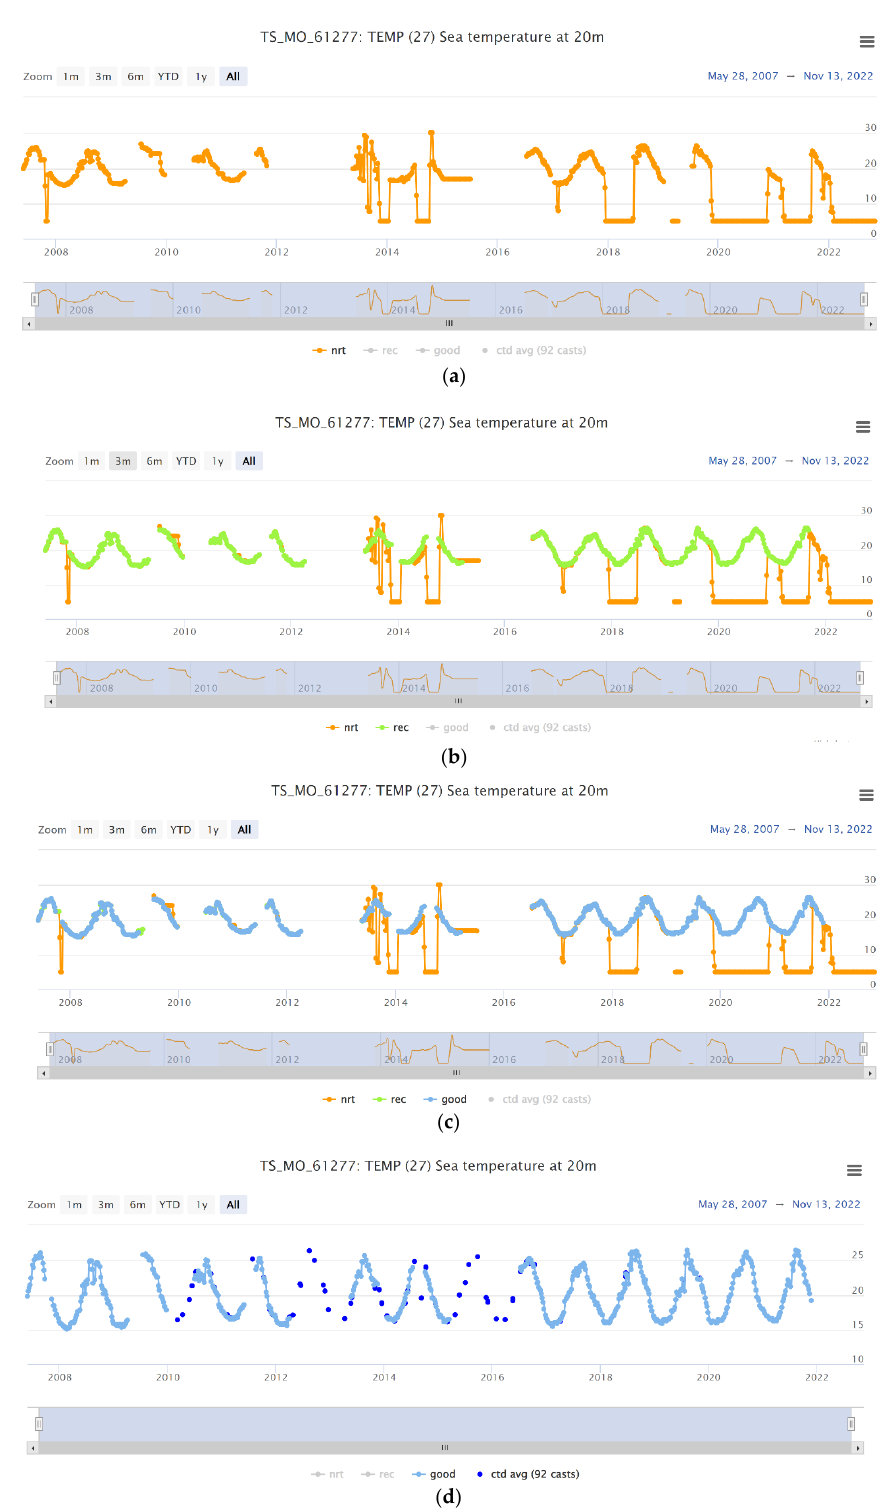
Figure 8. The POSEIDON buoys data flow using as an example the E1M3A 20 m temperature timeseries. Panel ( a ) corresponds to the NRT data received for the station during the deployment period. Panel ( b ) also includes the delayed mode data after the retrieval form the internal logger of the instrument and the process. Panel ( c ) presents the data after the first automated quality control, and panel ( d ) — the final data product after all the delayed quality control procedures and the field validation comparison.